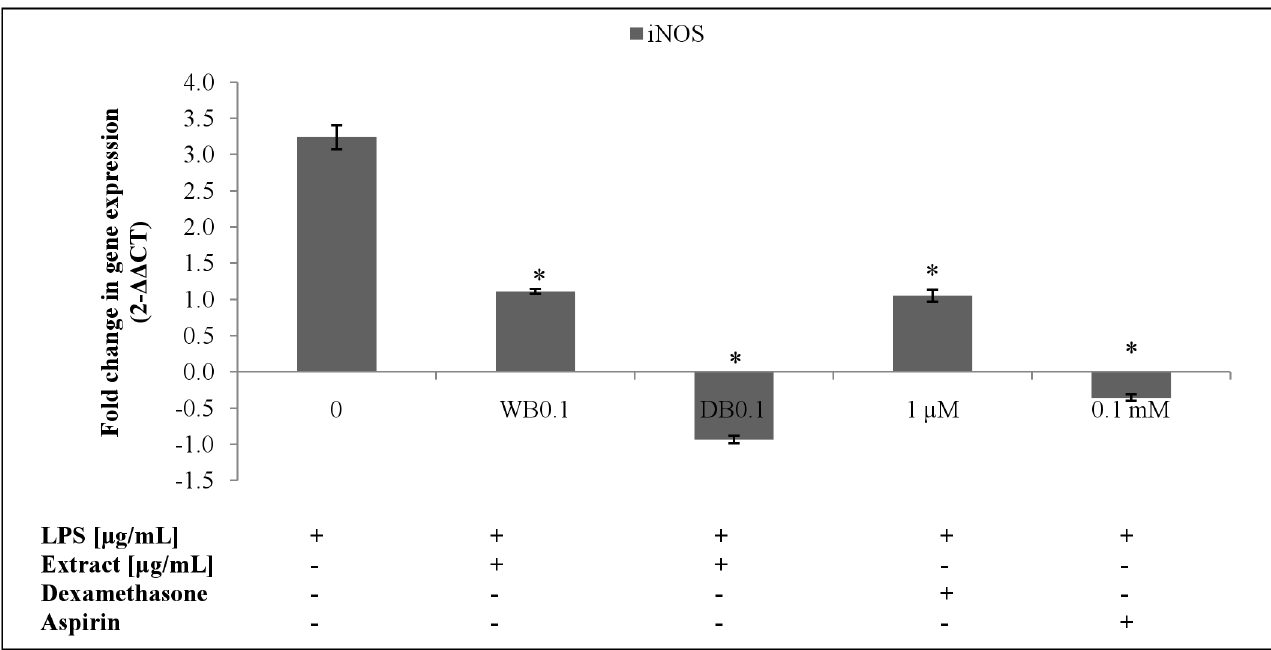
Fig 4. Effects of A . rugosum extracts on iNOS gene expression (S1 Dataset). RAW264.7 cells were co-incubated with A . rugosum extracts (WB0.1: 0.1 μ g/mL WB; DB0.1: 0.1 μ g/mL DB) and 1 μ g/mL LPS for 24 hrs. Dexamethasone (1 μ M) and aspirin (0.1 mM) served as positive controls. β -actin was used as loading control and normalised against the treated group. Results shown represent the mean ± SEM, n = 3 and * p < 0.05 versus LPS-induced NO level alone.